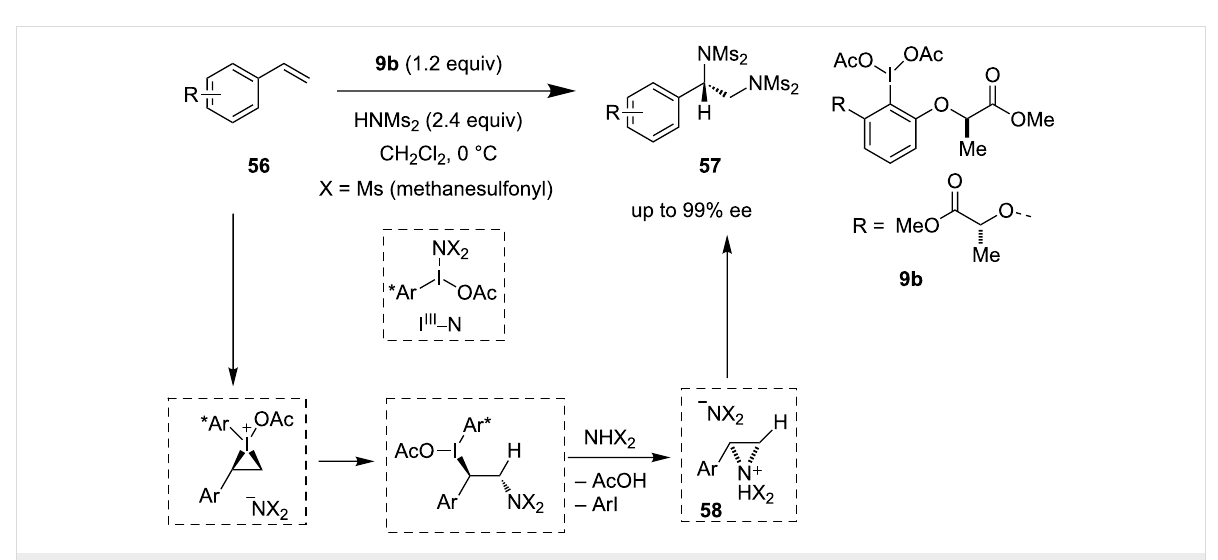
Scheme 12: Asymmetric diamination of alkenes.